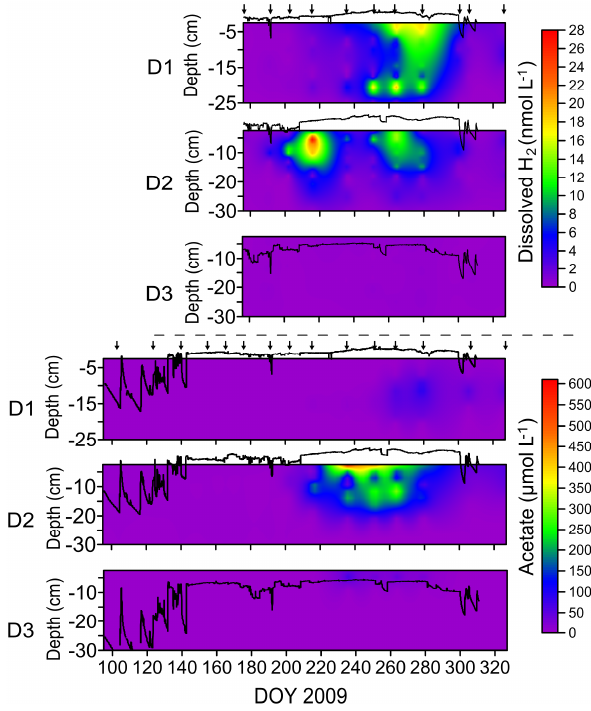
Fig. 9. Dissolved hydrogen and acetate concentrations during flood- ing (D plots). No or weak and sporadic accumulation occurred in C plots (see